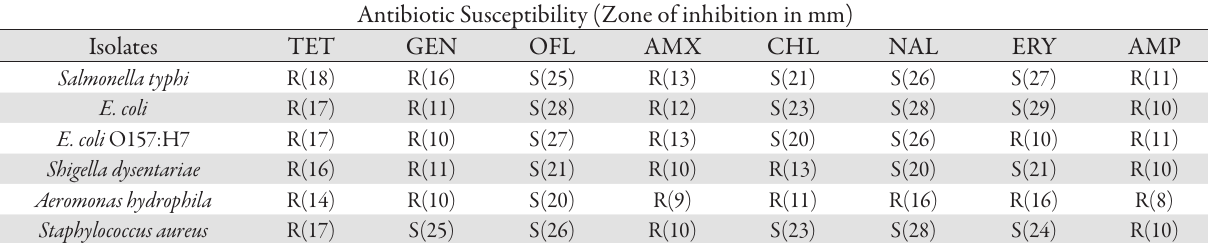
Tab. 1. Antibiotic Resistance profile of pathogenic bacteria isolates from Cow Dung used to fertilize fish ponds in New Bussa Nigeria